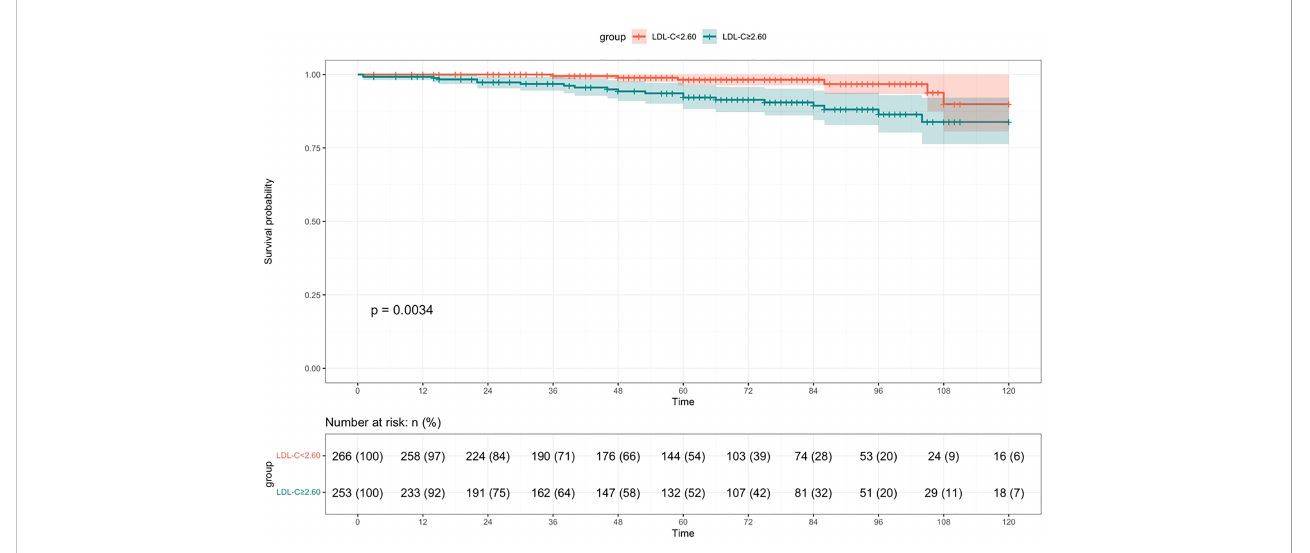
FIGURE 2 Survival rate of patients in the high LDL-C group compared to the low LDL-C group with IgAN (Kaplan-Meier survival